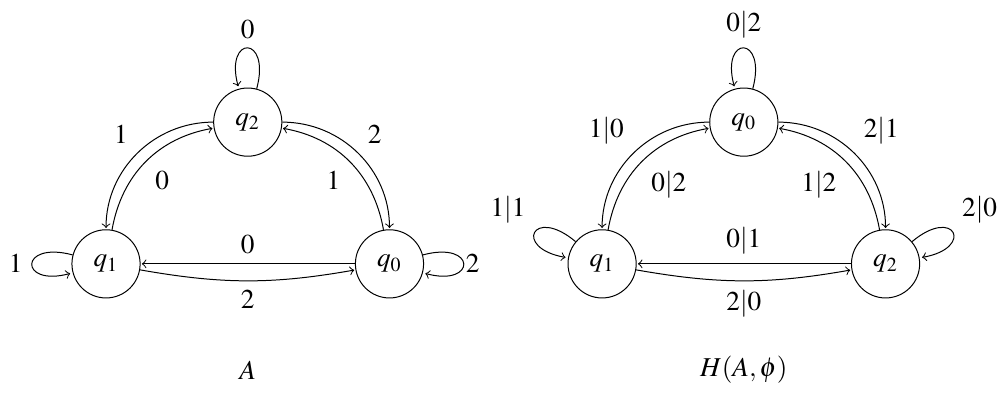
Figure 5: The transducer arising from the automorphism swapping vertices q 0 and q 1